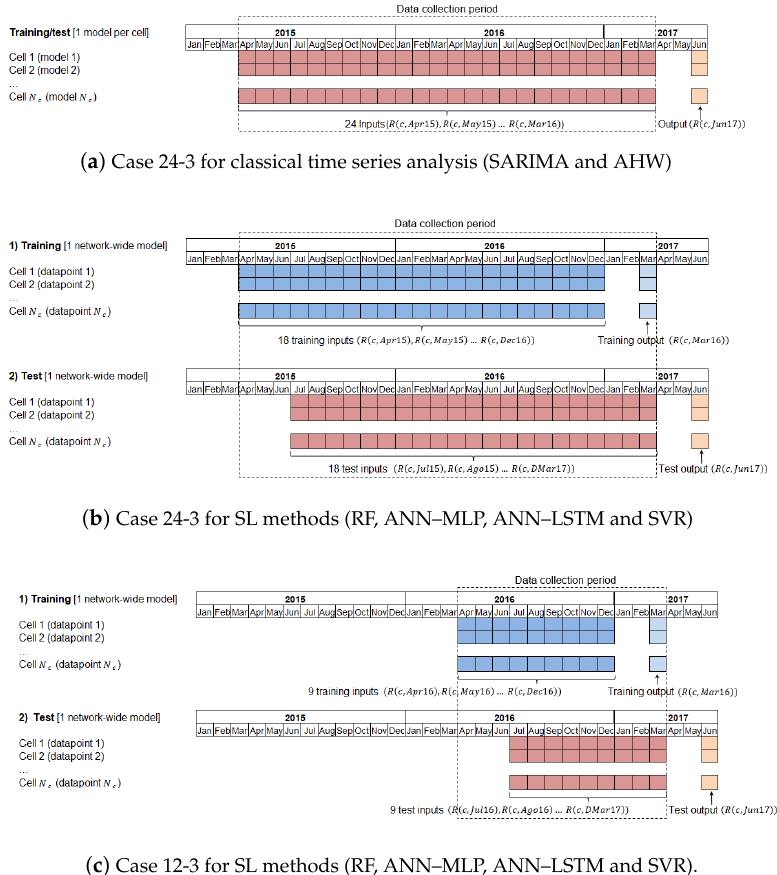
Figure 3. Timeline of prediction methods in cases 24-3 and